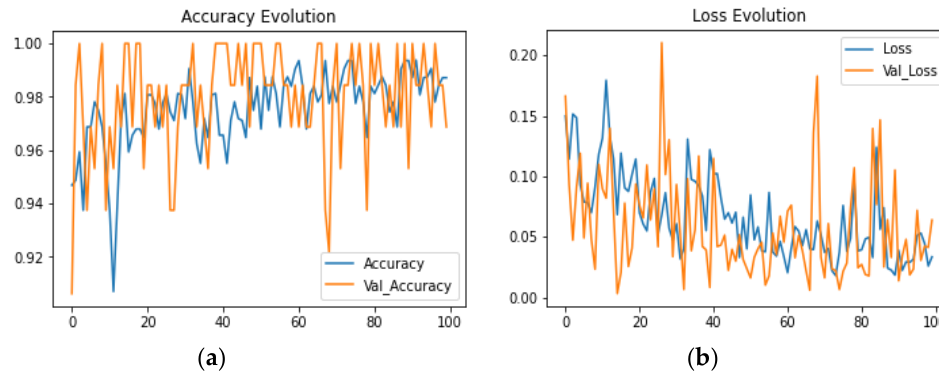
Figure 8. Accuracy evolution: ( a ) picture; ( b ) loss evolution.